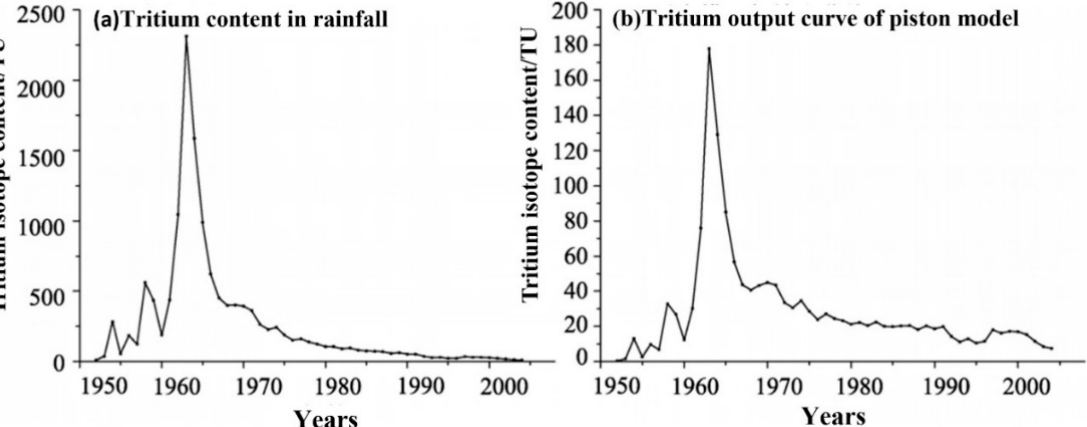
Figure 4. The historical concentrations of tritium in precipitation ( a ) and water determined by the piston model ( b ).